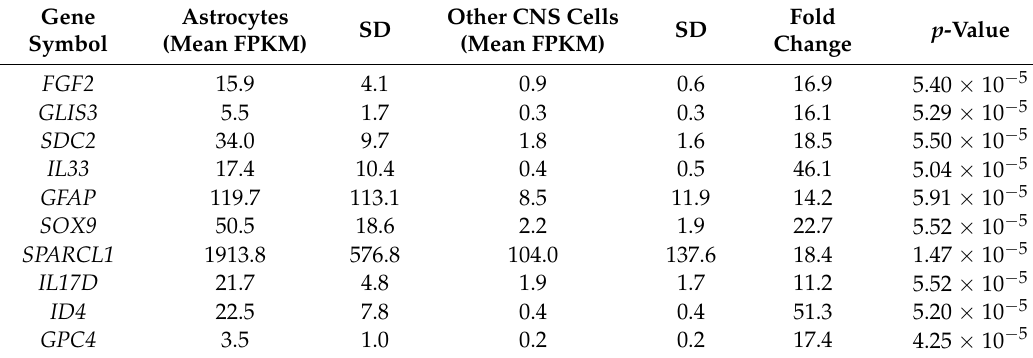
Table 4. List of functionally-relevant genes that co-express with Cx43 / GLA1 in spinal cord periplaque areas and harbor an astrocyte-specific profile in normal mature human